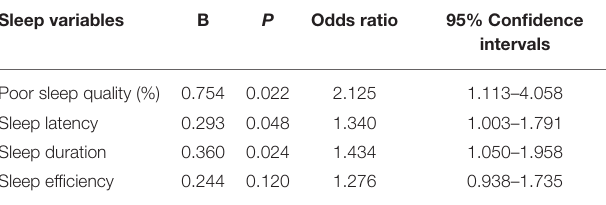
statistical significance in the score of sleep disturbances,